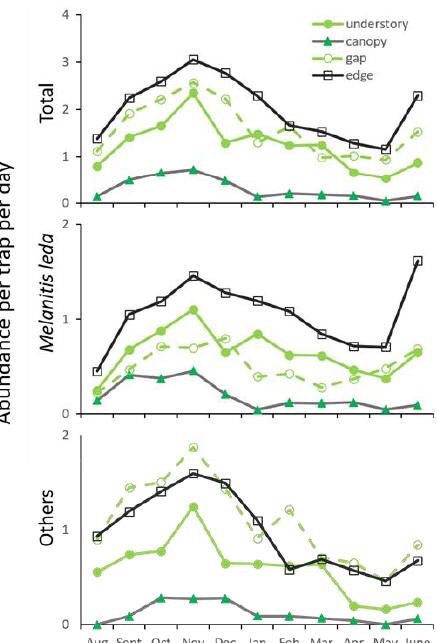
Figure 3. Temporal variation in fruit-feeding butterfly abundance (all species combined, the most common species, the remaining species combined) in the four principal habitats in Silent Valley National Park, Western Ghats,